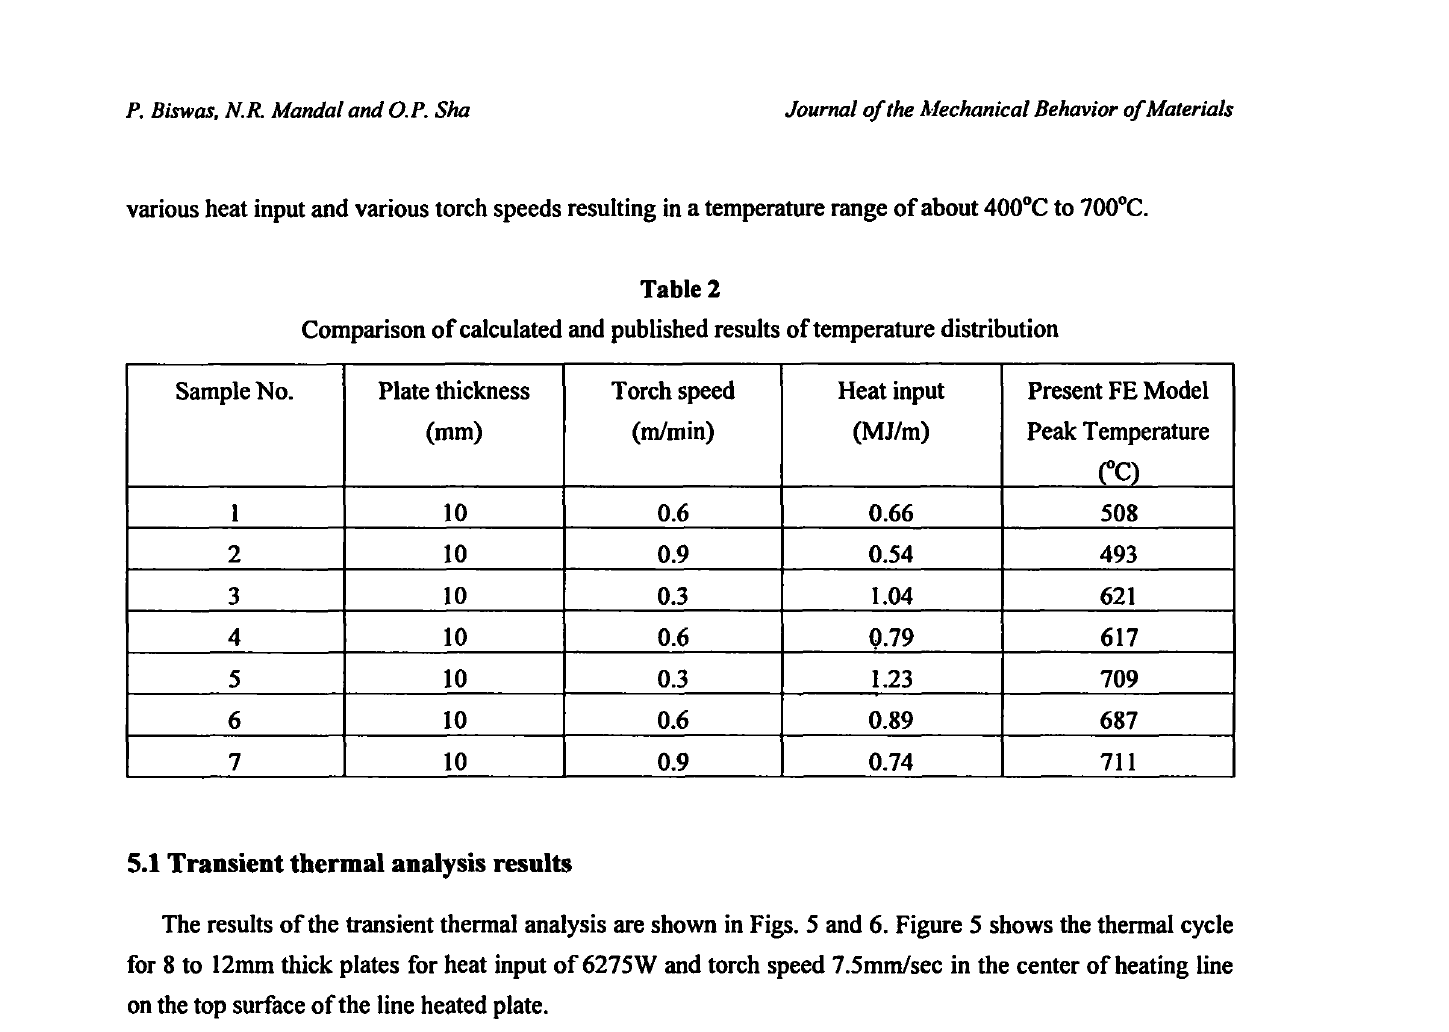
Comparison of calculated and published results of temperature distribution Sample No.